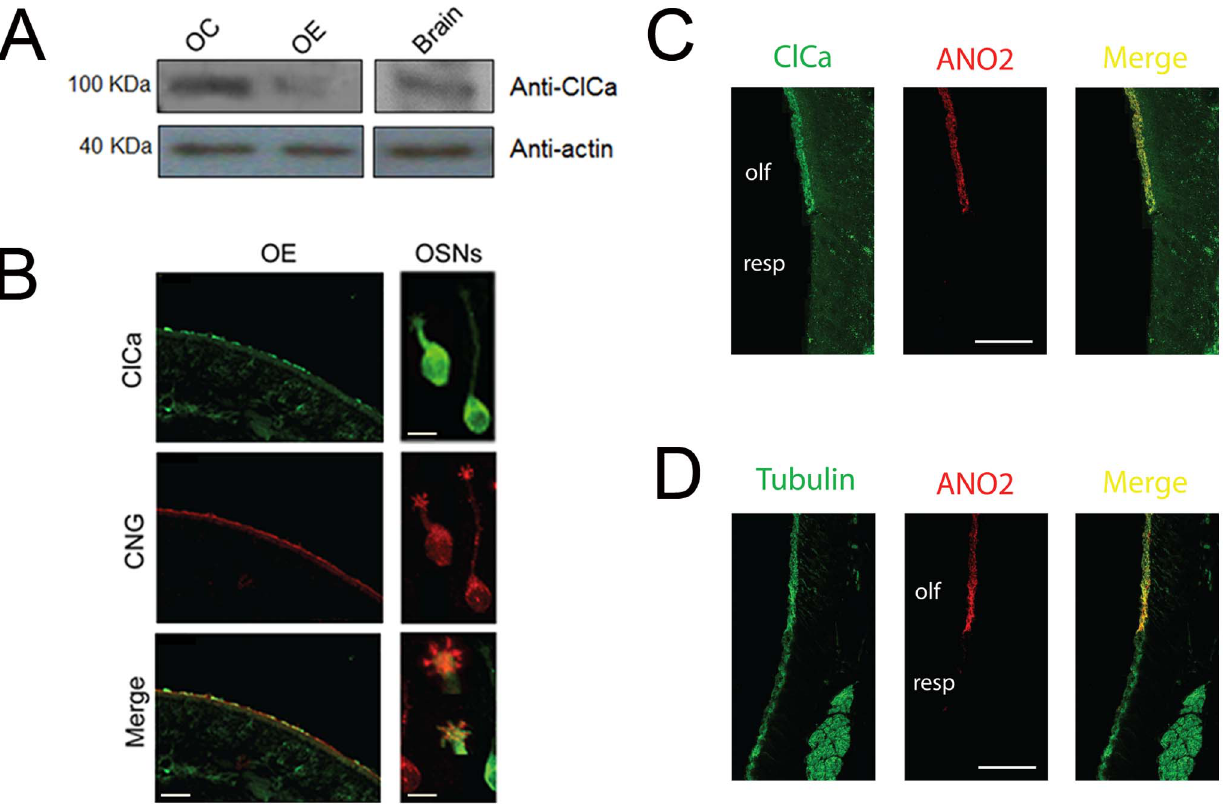
Figure 4. Western blot and immunohistochemical localization of ClCa to the olfactory cilia. A. Western blots of an enriched ciliary membrane preparation (OC), olfactory epithelium membranes (OE) and brain (positive control) samples using the anti-ClCa and the anti-actin antibodies. B. Immunolabeling of the olfactory epithelium (left panels) and of dissociated olfactory neurons (right panels) using specific anti-ClCa (green) and anti-CNGA2 (red) antibodies. Please note that in the dissociated cells the antibody immunoreactivity was found in the cilia, but there was also immunoreactivity in the cell body likely due to leakage of the ciliary proteins to the cell body after dissociation. Calibration bars in B: left, 10 m m; right top, center, 10 m m; right bottom, 2 m m. C and D. Immunolabeling of the olfactory and respiratory epithelia by anti-ClCa, anti-ANO2 known to label the olfactory cilia [16] and anti-acetylated tubulin that labels the cilia layer in both the olfactory and respiratory epithelia. Bars are 50 m m. C. The ciliary layer of the olfactory epithelium is labeled by both anti-ClCa (green) and anti-ANO2 (red). D. Both the respiratory and olfactory ciliary layers are labeled by anti-acetylated tubulin (green). The olfactory epithelium is identified by labeling with anti-ANO2 (red).